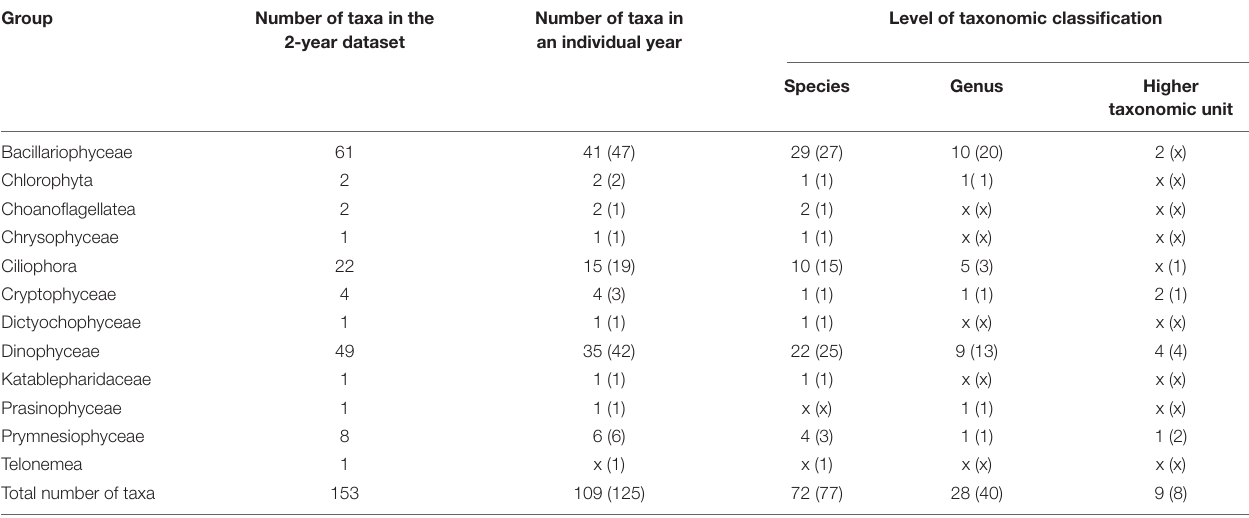
TABLE 1 | The number of taxa of individual protist groups observed in the study according to the different taxonomic classification levels. Group Number of taxa in the Number of taxa in 2-year dataset an individual